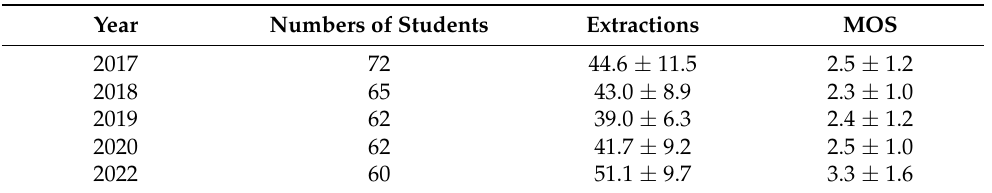
Table 3. Numbers of extractions and surgical procedures (MOS) for final year cohort of students in 2017–2022, given as the mean ± standard deviation.